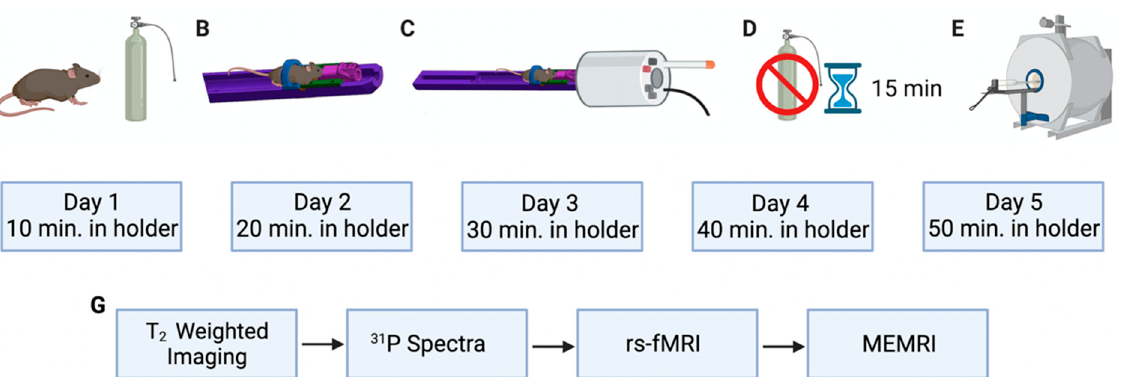
Figure 2. Acclimation Chamber. The simulated acclimation core was cut from PVC pipe and measures 600 mm in total length (300 mm for the core and 300 mm for the open extension). The width of the PVC pipe was 80 mm and the entire core was elevated 102 mm off the platform by a steel rack. The core was designed to mimic a small animal MRI core so that animals acclimated using this structure would exhibit lower stress signals and perform fewer and less drastic head movements during scans.